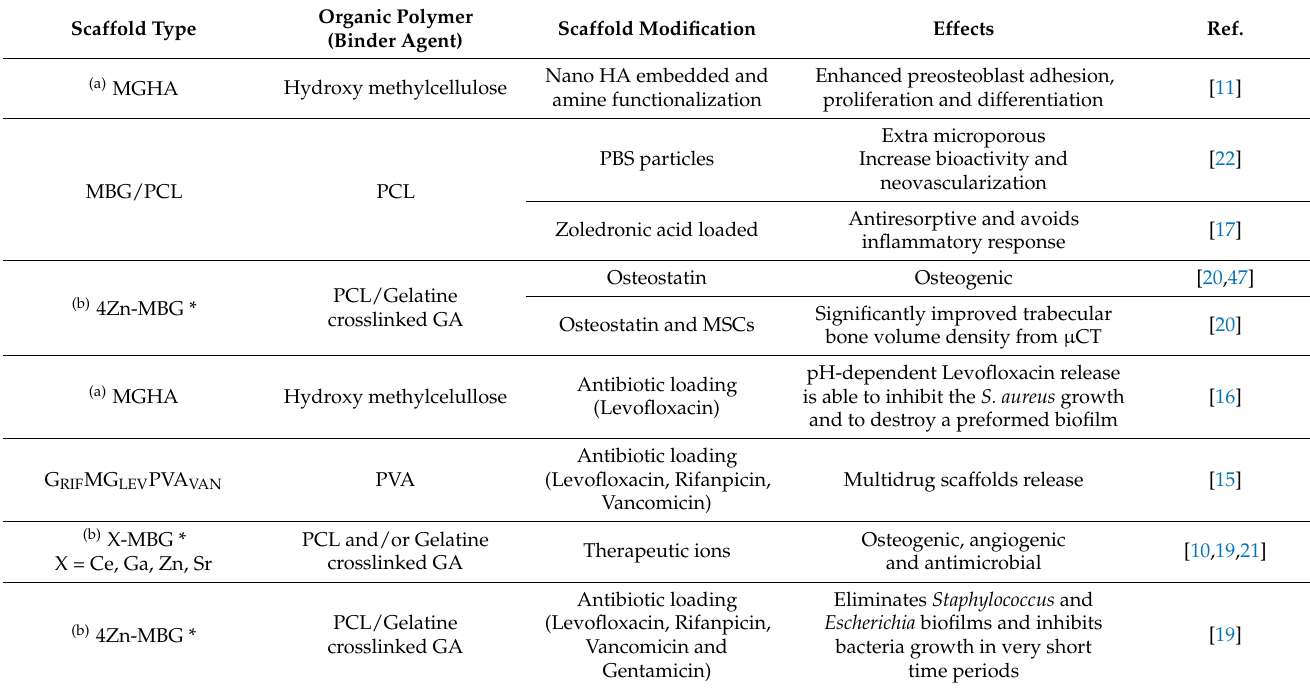
Table 2. The 3D scaffolds formed by ceramic matrix of MBGs and manufactured by rapid prototyping method. Organic Polymer Scaffold Type (Binder